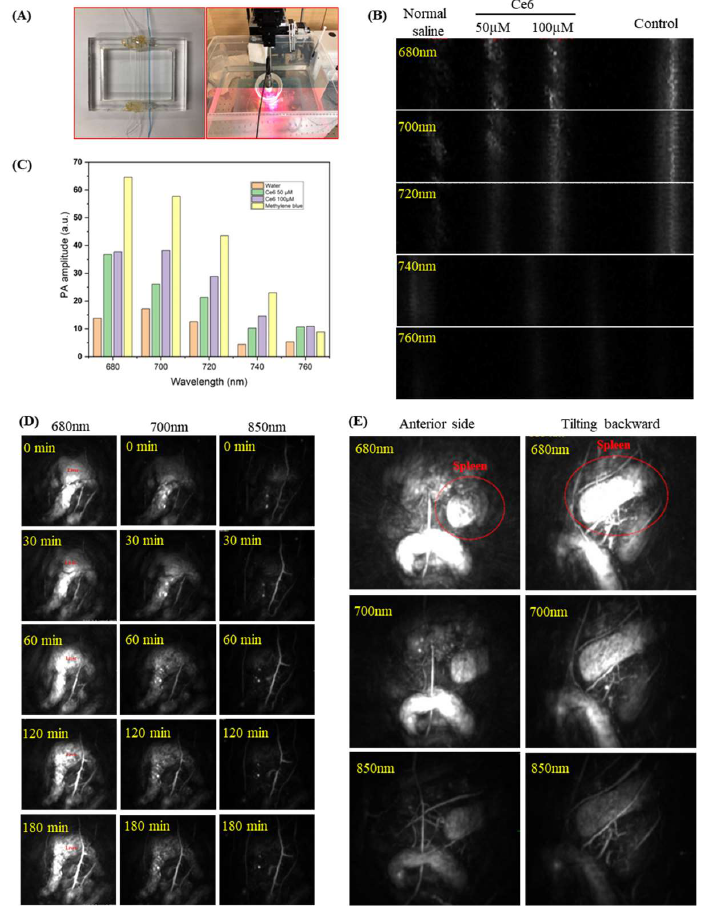
Figure 5. PA imaging potential of contrast agent Ce6. ( A ) In vitro PA imaging setup showing normal saline, Ce6 (50 and 100 µ M), and methylene blue in the tubes. ( B ) PA images. ( C ) PA signal intensity of Ce6 at different concentrations and wavelength. In vivo ( D ) PA images of mouse liver at 0, 30, 60, 120 and 180 min. post intravenous injection of Ce6. ( E ) PA images of mouse spleen at 680, 700 and 850 nm wavelength from anterior side and after tilting slightly